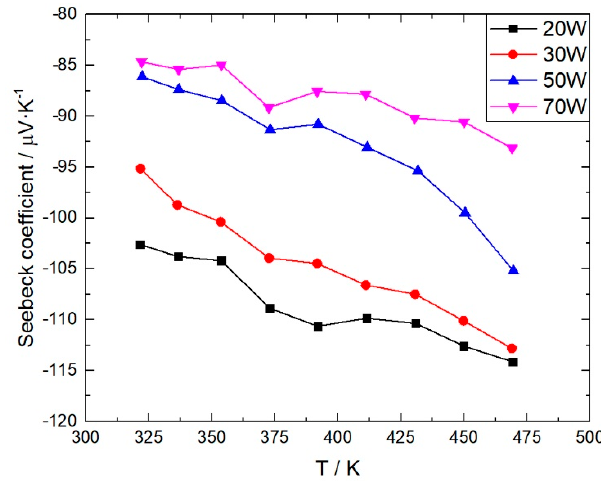
Figure 6. Seebeck coefficients of the Bi 2 Te 3 films deposited under different powers